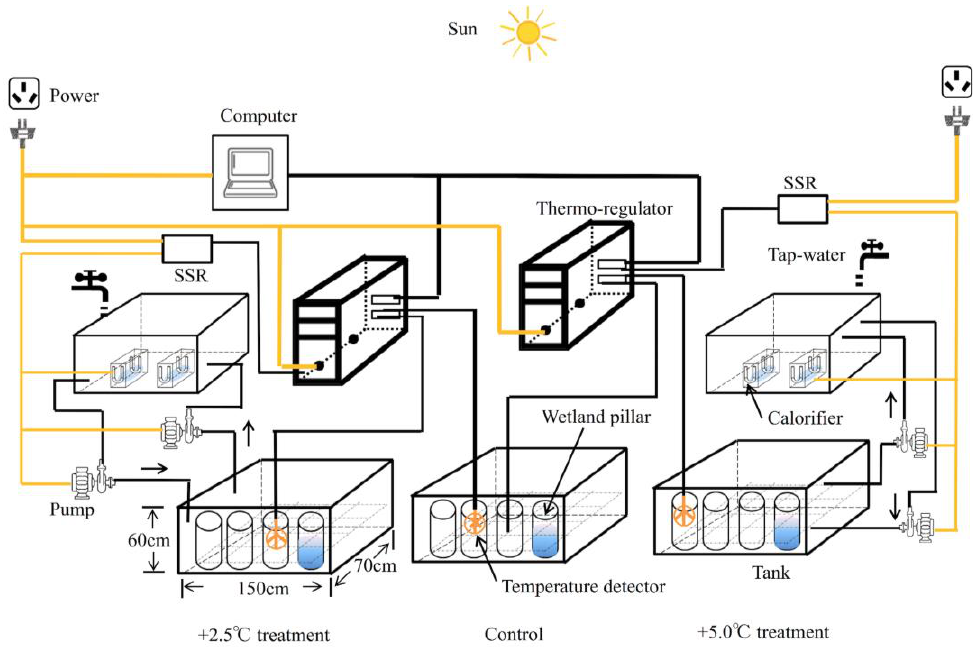
Figure 1. The experiment device of the simulation micro-environment under global warming conditions in geographically-isolated wetlands (GIWs) (left: control group +2.5 °C, low-warmed; middle: ambient water temperature, control; right: control group +5.0 °C, high-warmed).